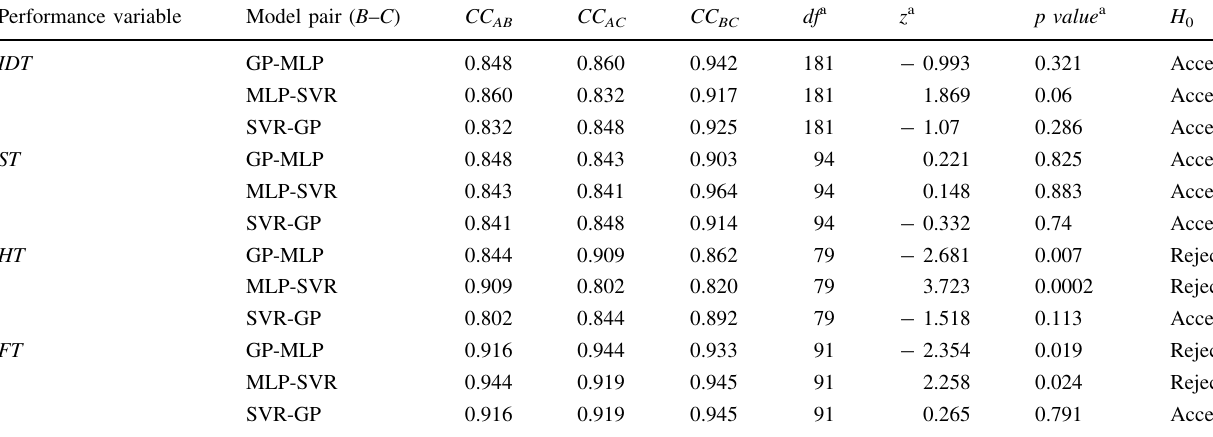
Table 6 Results of the Steiger’s Z-test (testing the null hypothesis H 0 , CC AB = CC AC ) Performance